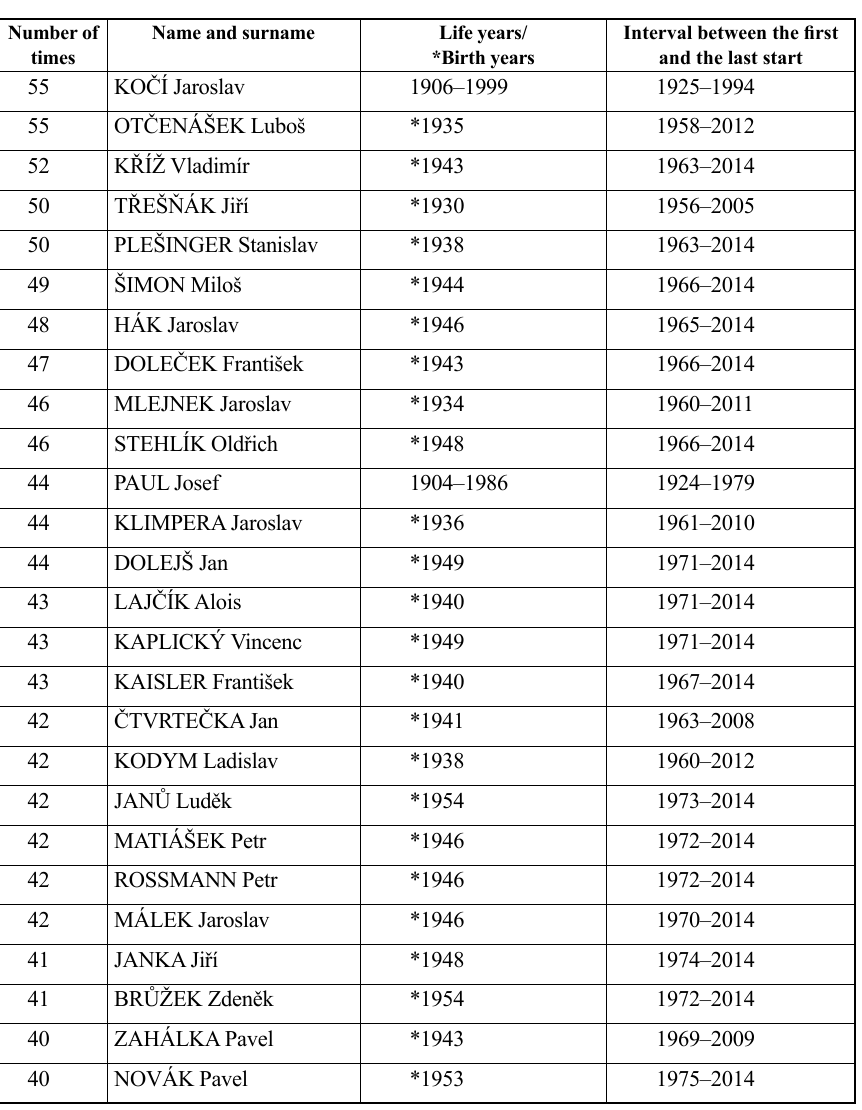
Figure 4. Number of runners in the traditional 10K running race called “Běchovice” – showing increase since